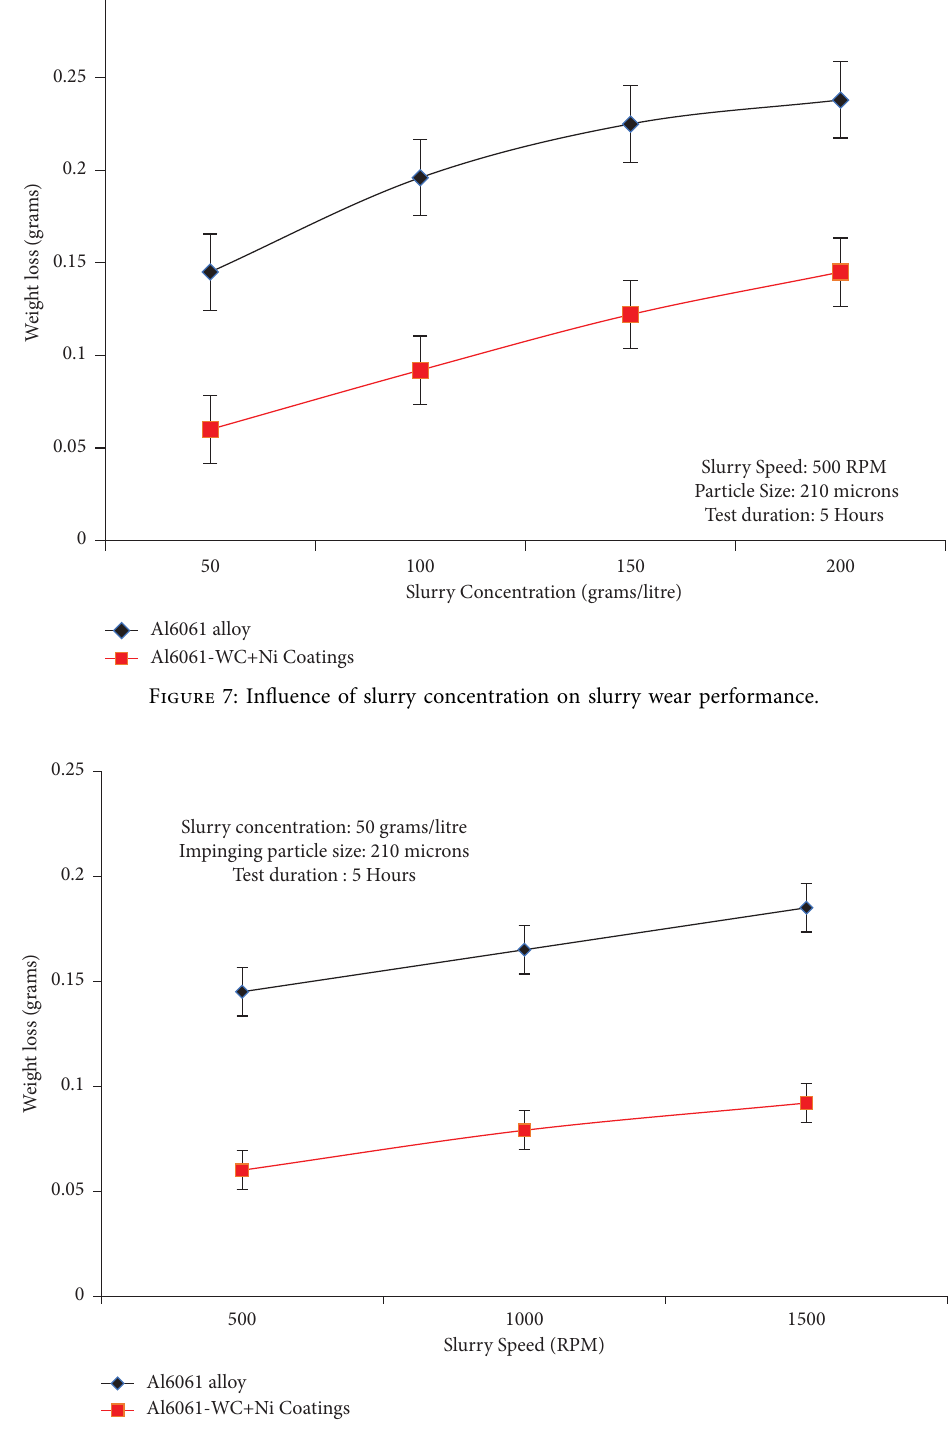
Figure 8: Infuence of speed on slurry erosive